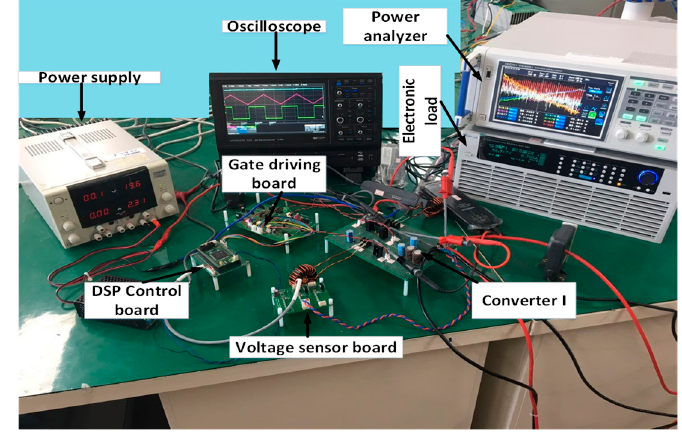
Figure 14. Experimental setup of proposed Converter I. Table 2. Parameters of the test